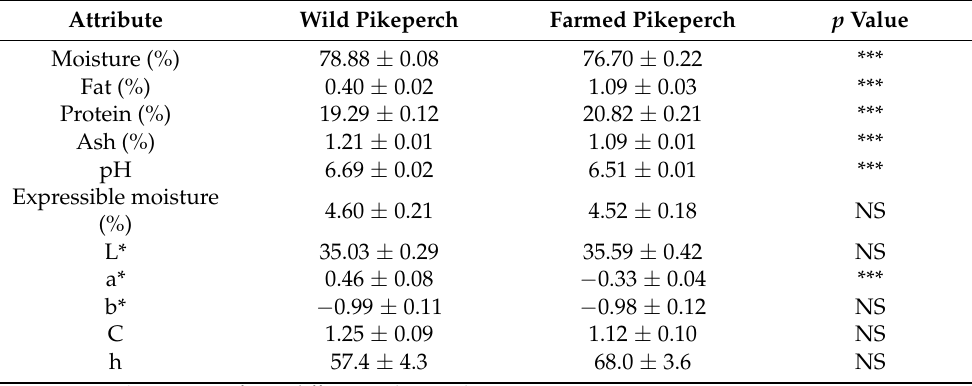
Table 3. Chemical composition and colour of raw wild ( n = 12) and farmed ( n = 12) pikeperch (mean values ± standard